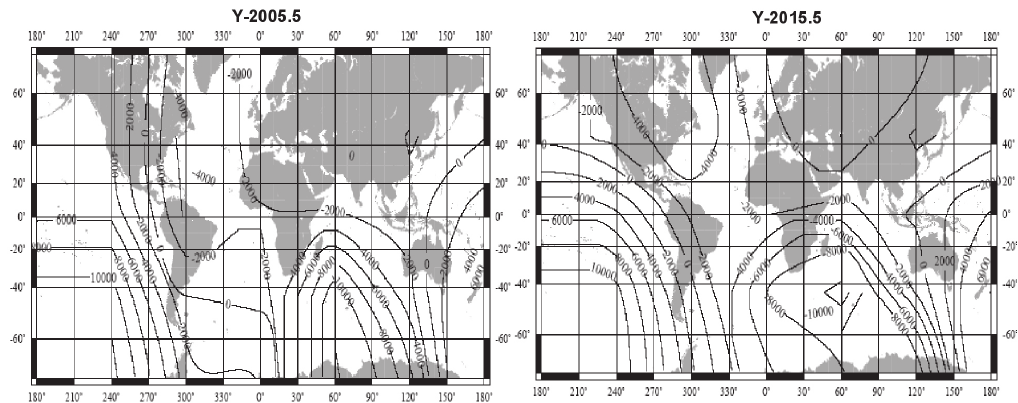
Fig. 10. Isolines of X-Component predicted by the Neural Networks for two different epochs.